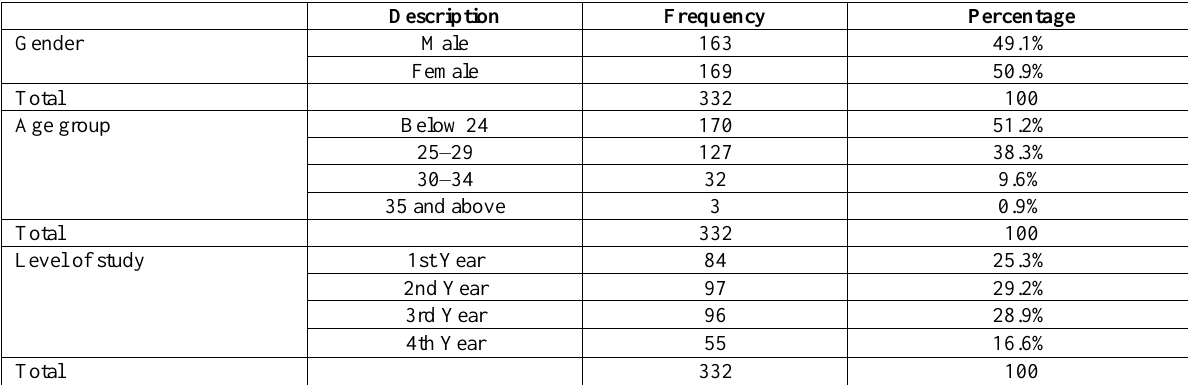
Table 1. Demographic Profile of Participants